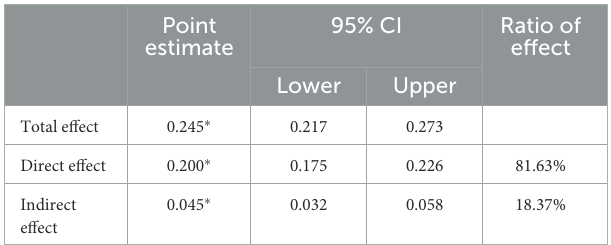
three moderated mediating models were all significant ( P < 0.01) (Supplementary Table 2). Compared with rural elderly, urban aged people had a stronger indirect effect of media use on health care (rural: B = 0.007, P < 0.05; urban: B = 0.021, P < 0.05), disease